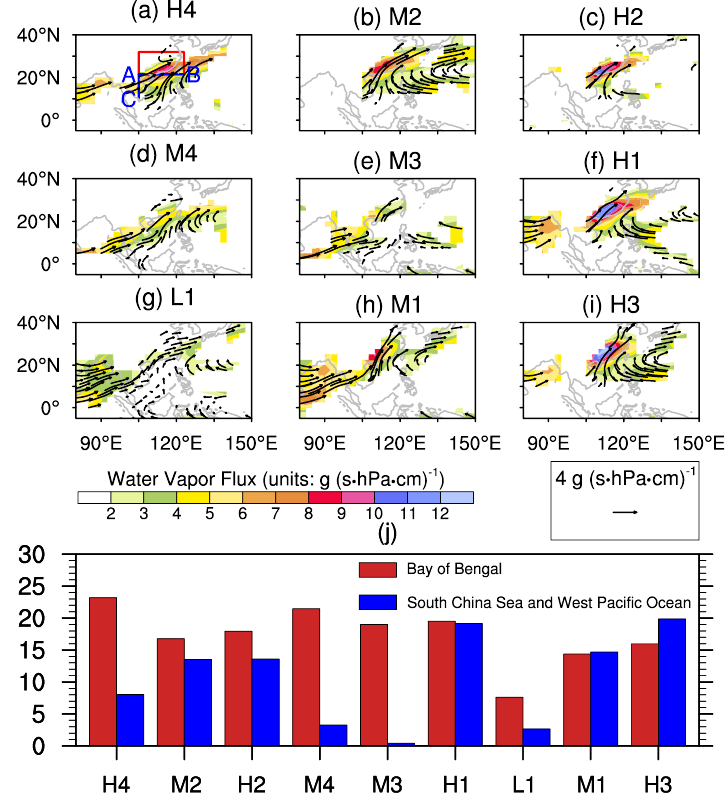
Figure 7. ( a – i ) Composite means of water vapor flux (shading; units: g (s · hPa · cm) − 1 ) and its vectors (vectors; units: g (s · hPa · cm) − 1 ) for the nine regimes during AMJ 1979–2015 and ( j ) the magnitudes of water vapor transport (units: 10 10 g s − 1 ) from the Bay of Bengal, and the South China Sea and West Pacific Ocean for the nine regimes. In ( a – i ), only composite means that pass the 95% confidence level based on two-sided Student’s t test against the complementary set of samples are plotted, and the vectors are plotted if only water vapor flux is significant in one direction (zonal or meridional). The red lines and blue AB line in ( a ) denote the region of South China (21.5–32 ◦ N, 105–123 ◦ E). The blue lines AB (21.5 ◦ N, 105–123 ◦ E) and AC (10.0–21.5 ◦ N, 105 ◦ E) are used to estimate the magnitudes of water vapor